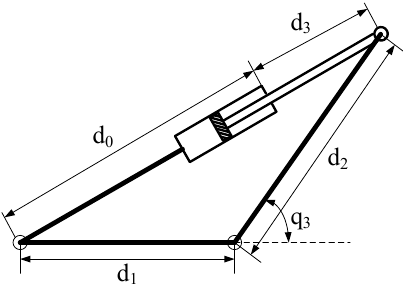
Figure 2. The architecture of the last link.